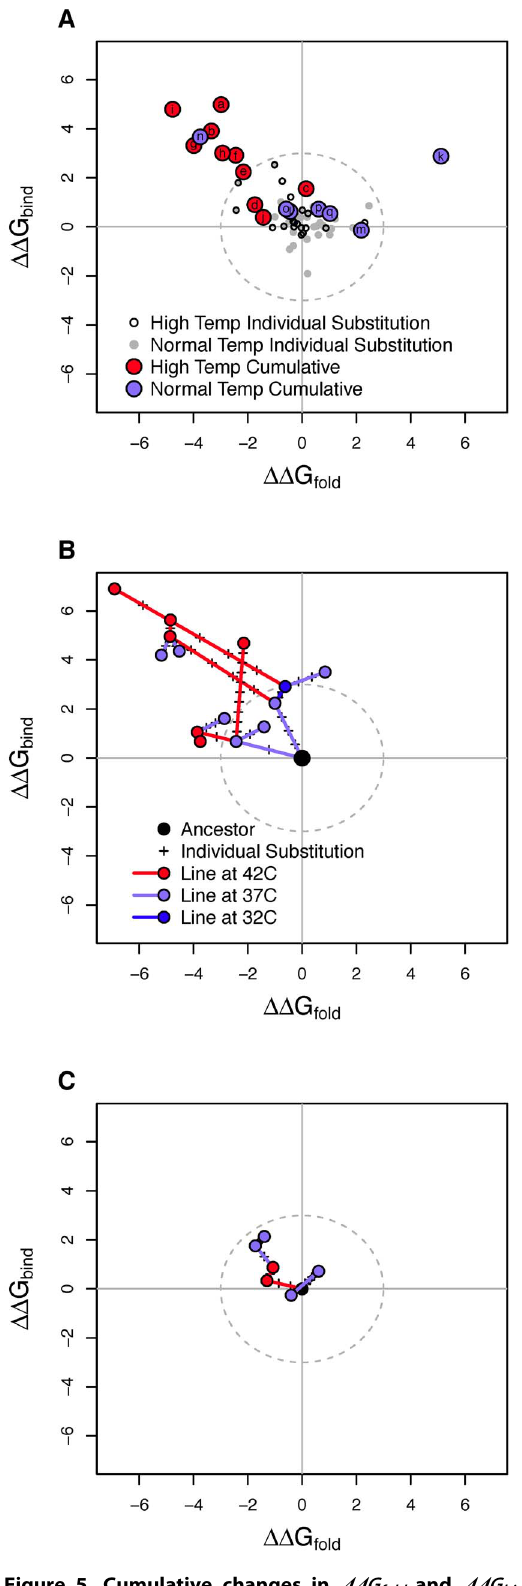
Figure 5. Cumulative changes in DD G fold and DD G bind across many lab adaptation experiments. The figure shows that cumulative stability changes frequently extend beyond individual changes and that high temperature changes are frequently beyond the range of individual changes and high temperatures (red) often